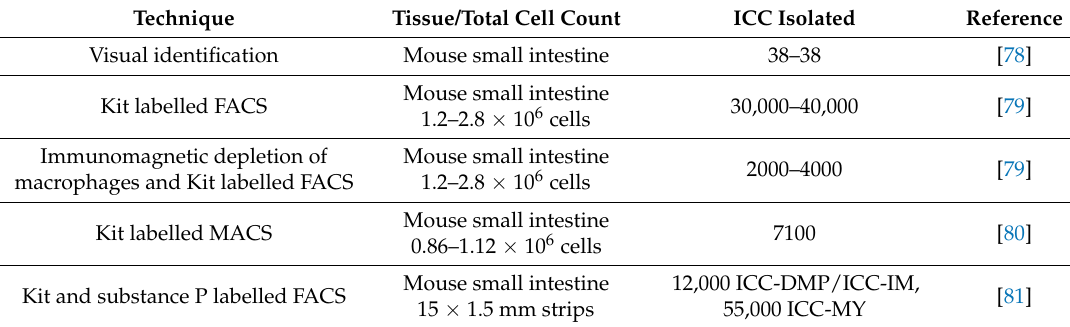
Table 2. Summary of ICC recovered from gastrointestinal